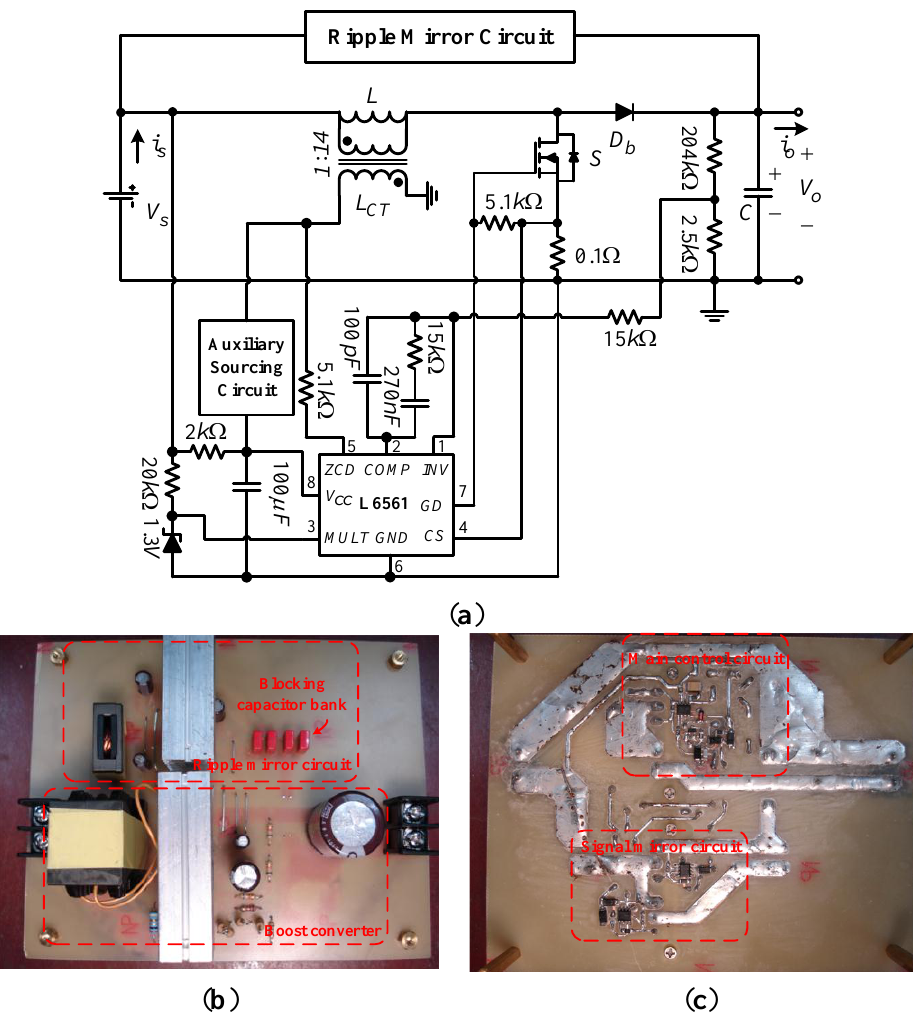
Figure 10. Experimental prototype of the proposed converter: ( a ) the circuit schematic; ( b ) top side view and ( c ) bottom side